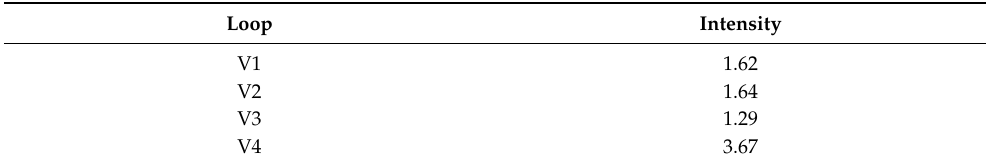
Table 1. Intensities corresponding to the cycles depicted in the diagram of the Figure 3. Every loop in the cycle of time is numbered as V i .